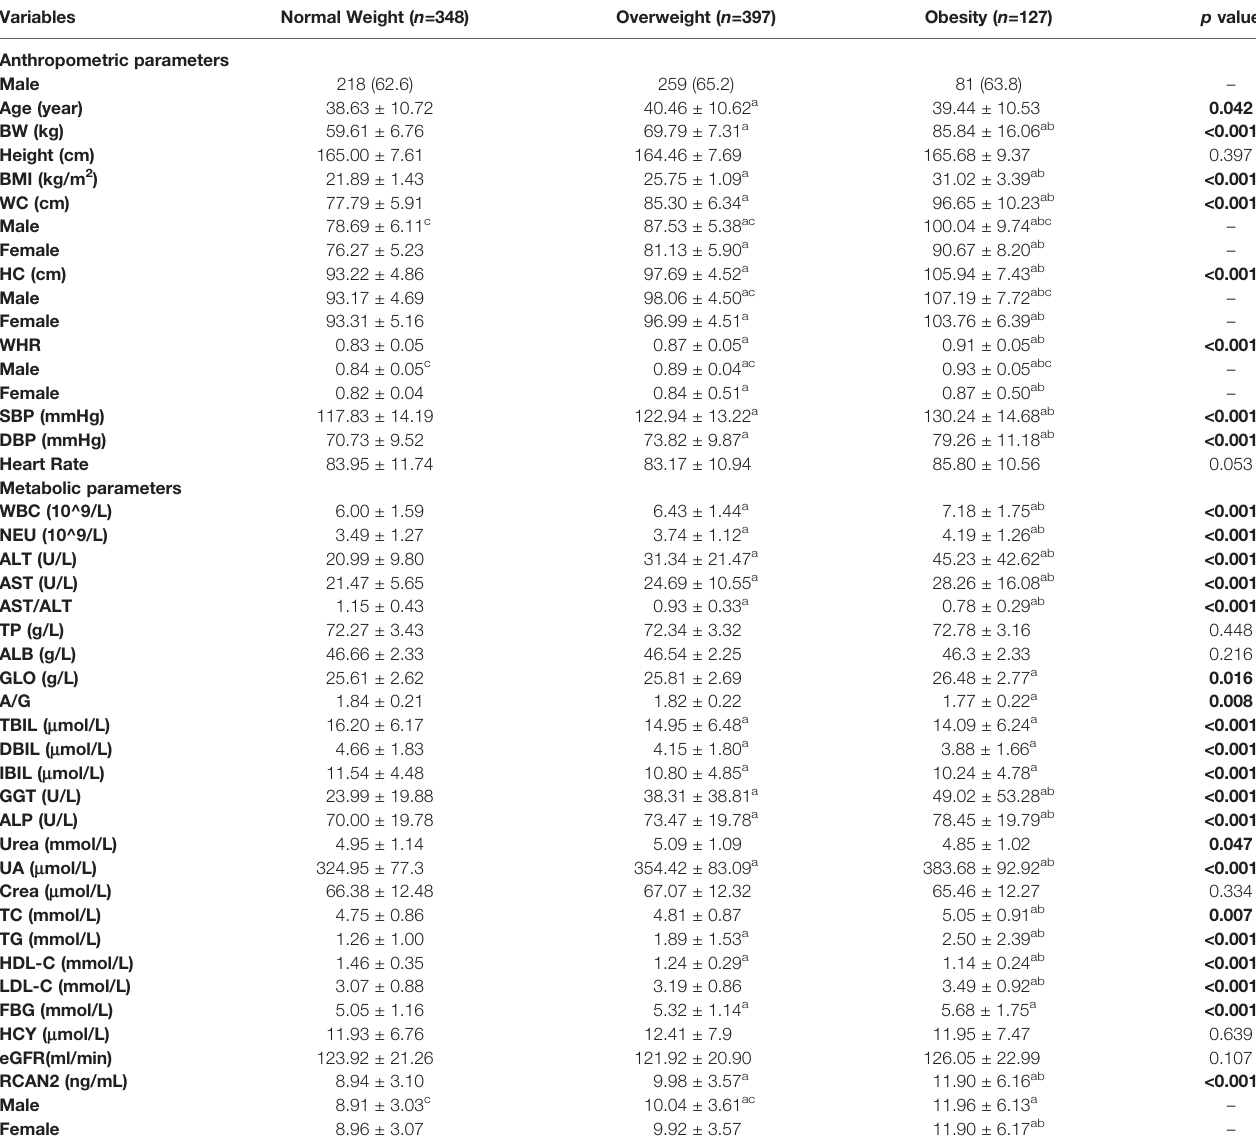
TABLE 1 | Baseline characteristics of participants according to BMI. Variables Normal Weight ( n